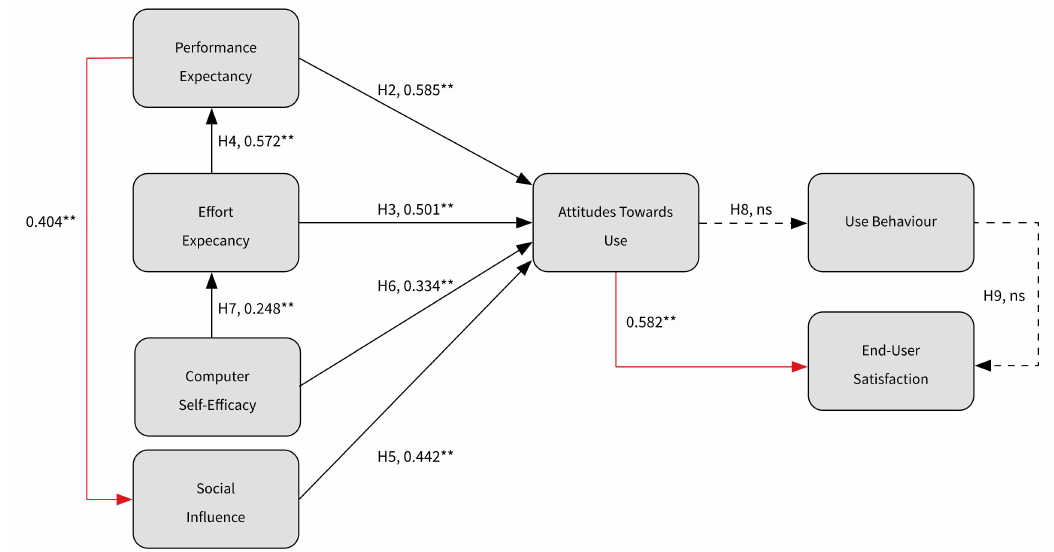
Figure 2. The constructed research model, based on the UTAUT, including newly discovered relationships (red line). ** p < 0.001. ns = not